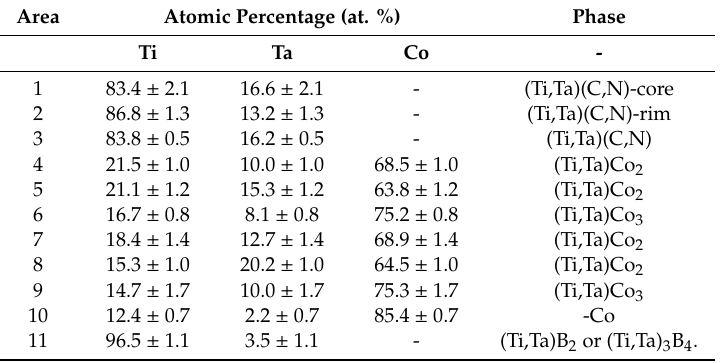
for both sets of (Ti,Ta)(C,N)-Co-B based cermets: s1B0 , s1B0.5 , s1B2 , s2B0 , s2B0.5 , and s2B2 .